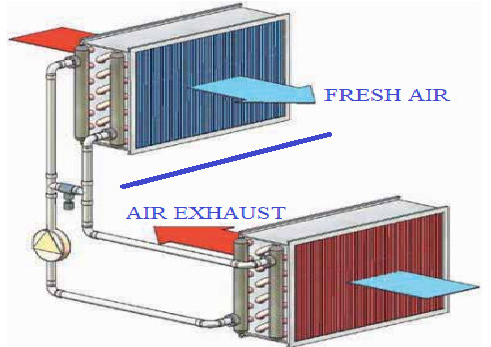
Figure 13. Round around coil-type heat recovery (data processed from reference [39]).